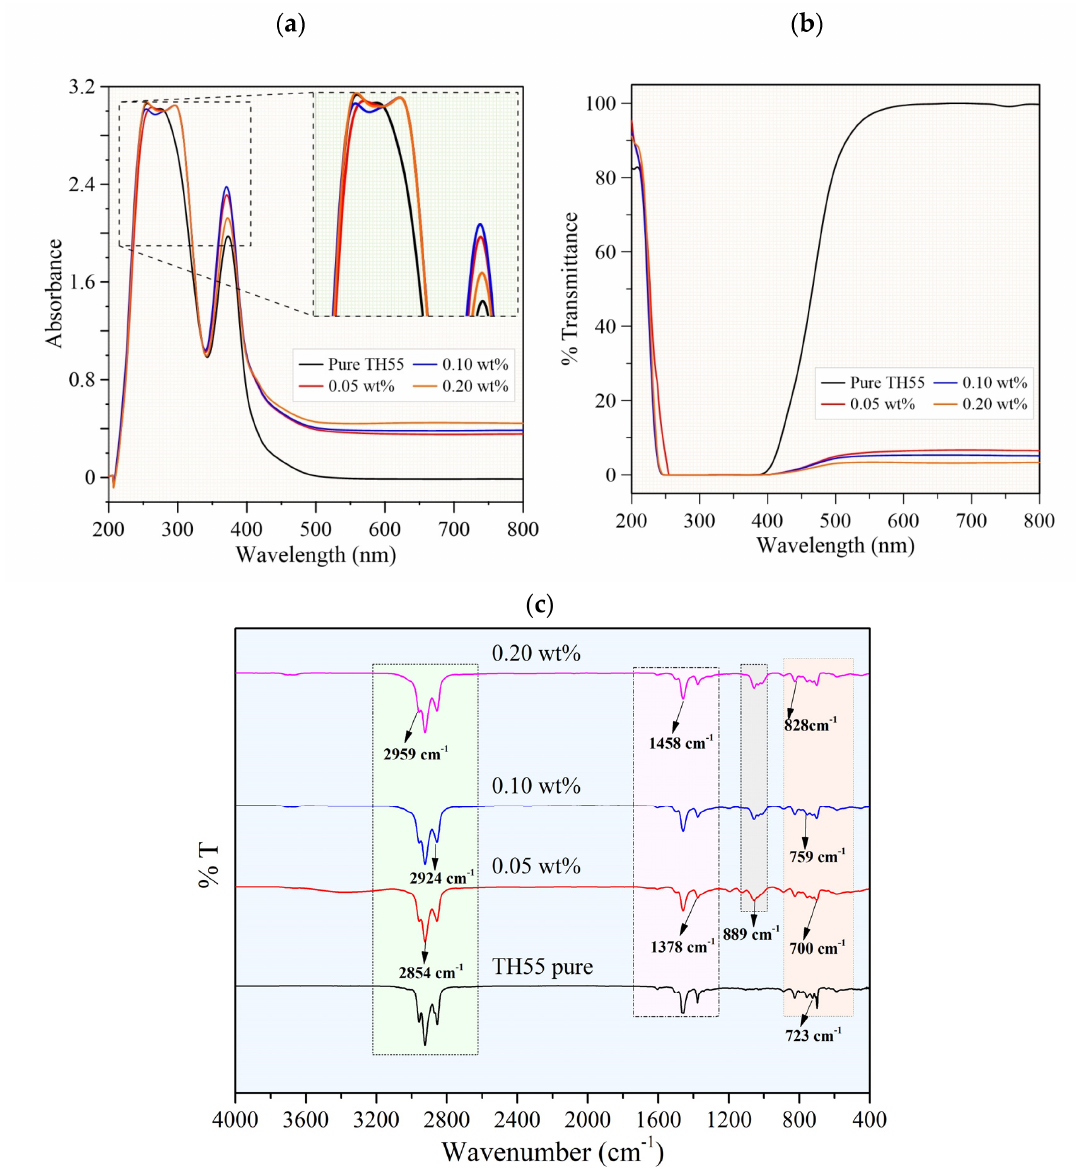
Figure 4. UV-Vis ( a ) Absorbance and ( b ) Transmittance spectra of hybrid TH-55/MXene + Al 2 O 3 nanofluids at different particle loadings, ( c ) FT-IR spectra of hybrid TH-55/MXene + Al 2 O 3 nanofluids at different particle loadings.